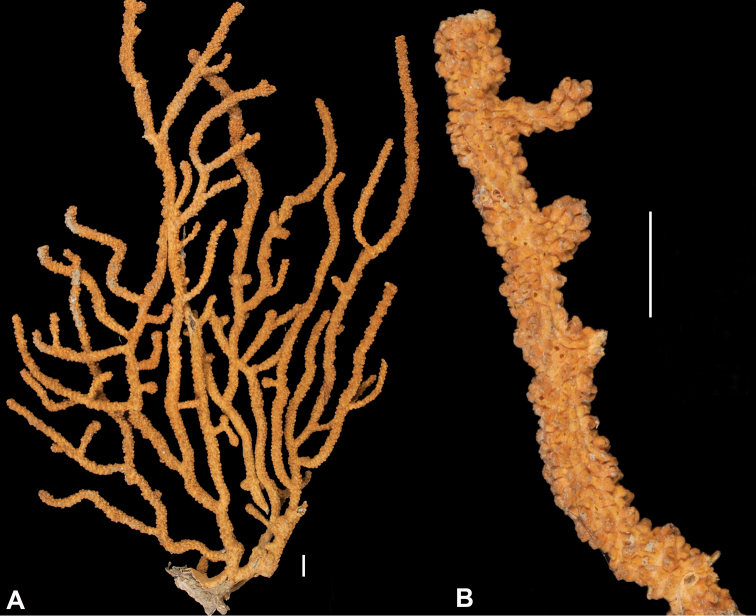
Muriceacalifornica, SBMNH 422921. A Whole colony, 25.5 cm × 15 cm B View of branch tip magnified to show prominent, somewhat rounded calyces.